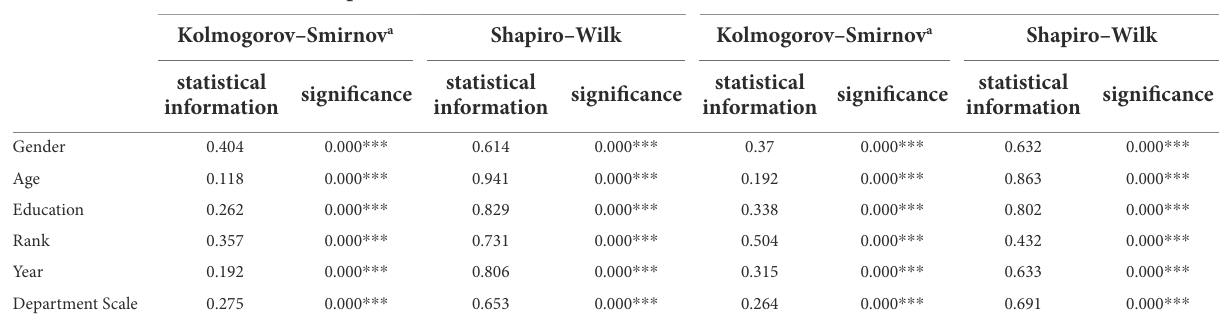
TABLE 2 Normal test of samples distribution.